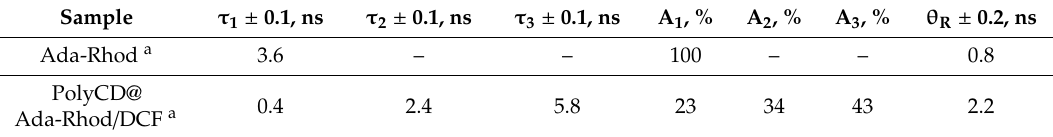
Table 2. Fluorescence lifetimes ( τ ) and rotational correlation time ( θ R ) of PolyCD@Ada-Rhod / DCF vs.